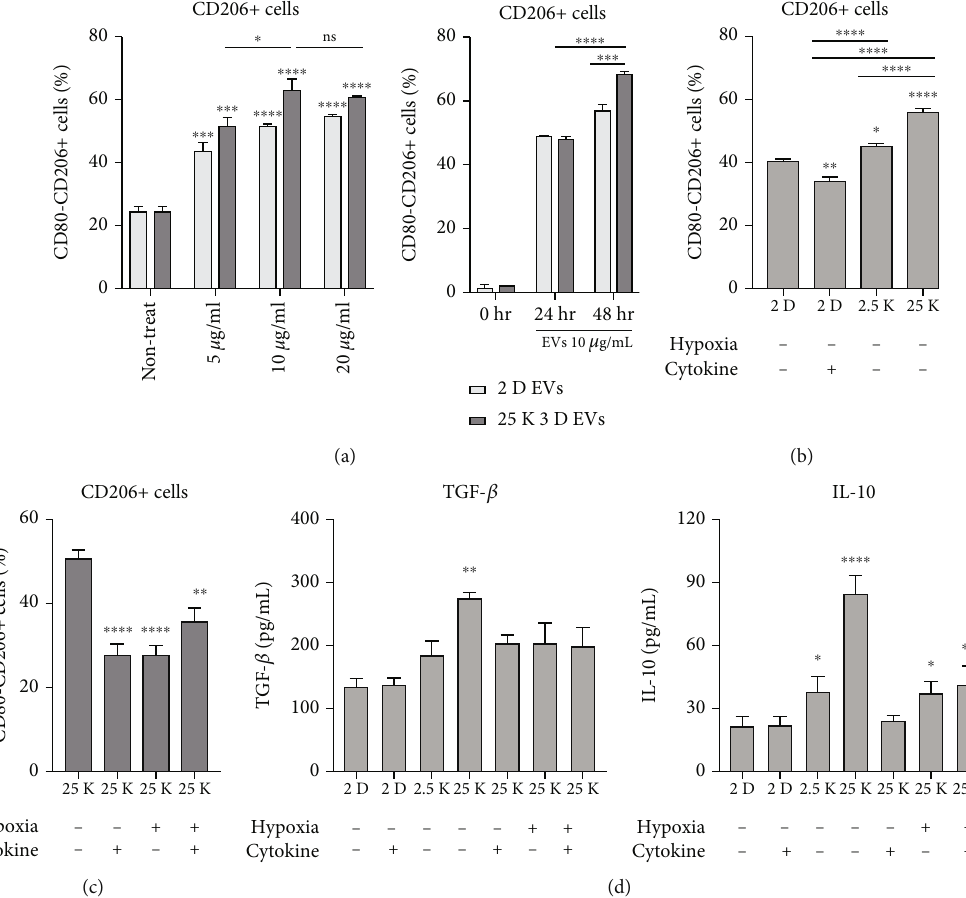
Figure 2: 3D hUCB-MSC-derived extracellular vesicles (EVs) and M2 polarization of pancreatic macrophages. (a) Flow cytometry analysis of cell surface molecules CD206 and CD80 on pancreatic macrophages cultured with monolayer (2D) and 25 K 3D hUCB-MSC-derived EVs. The error bars represent the standard deviation of measurements in three separate sample runs ( n = 6 ). Signi fi cance of di ff erence was determined using two-way analysis of variance (ANOVA) with Tukey ’ s posttest. (b) Flow cytometry analysis of cell surface molecules CD206 and CD80 on macrophages cultured in the presence of EVs isolated from the supernatants of 2D- or 3D-cultured (2.5 K and 25 K) hUCB-MSCs. The error bars represent the standard deviation of measurements in three separate sample runs ( n = 6 ). (c) Flow cytometry analysis of cell surface molecules CD206 and CD80 on pancreatic macrophages cultured in the presence of EVs isolated from the supernatants of hUCB-MSCs that were unstimulated or preconditioned with hypoxia or cytokines (TNF- α and IFN- γ , each 40ng/mL). The error bars represent the standard deviation of measurements in three separate sample runs ( n = 6 ). (d) Medium concentrations of TGF- β and IL-10 were measured by ELISA. The error bars represent the standard deviation of measurements in three separate sample runs ( n = 8 ). Signi fi cance of di ff erence was determined using one-way ANOVA with Tukey ’ s posttest. Columns, mean; bars, SD. ∗ p < 0 : 05 , ∗∗ p < 0 : 005 , ∗∗∗ p < 0 : 0005 , and ∗∗∗∗ p < 0 : 0001 compared to the control